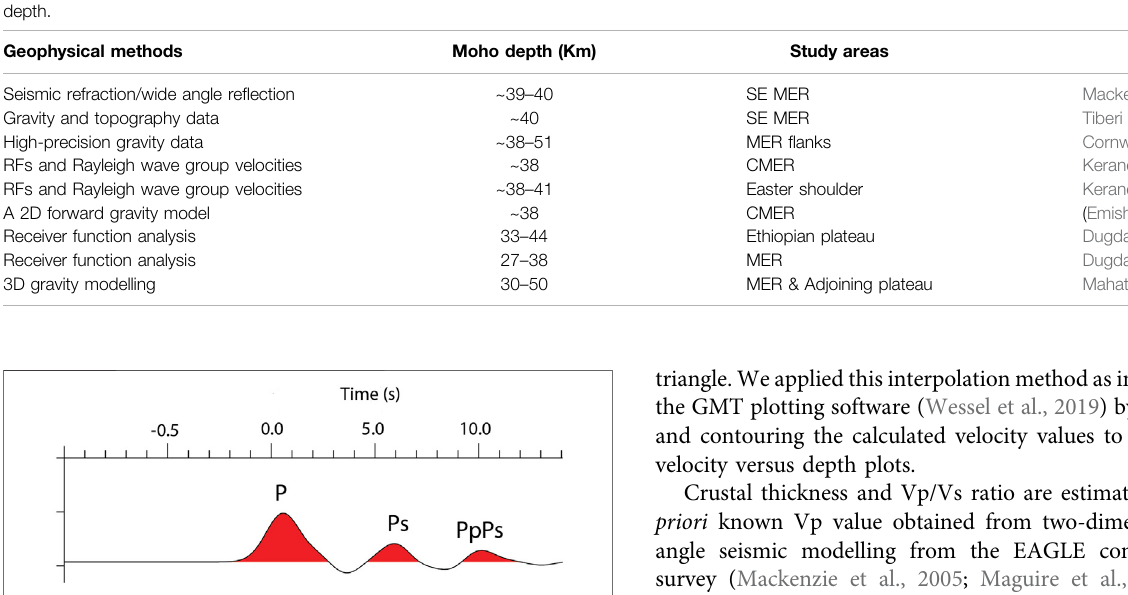
Figure 6 indicates the 1D velocity models for the chosen two stations. These velocity models are calculated from the blue-coloured synthetic RFs shown in Figure 5 . They are calculated in the depth range of 2 – 100 km. The blue-coloured nearly vertical line is the initial velocity model, which is assumed as a homogeneous half space with a Vs of ~4.48 km/s, which is the value of most of the lithosphere in the ak135 velocity model (Kennett et al., 1995).